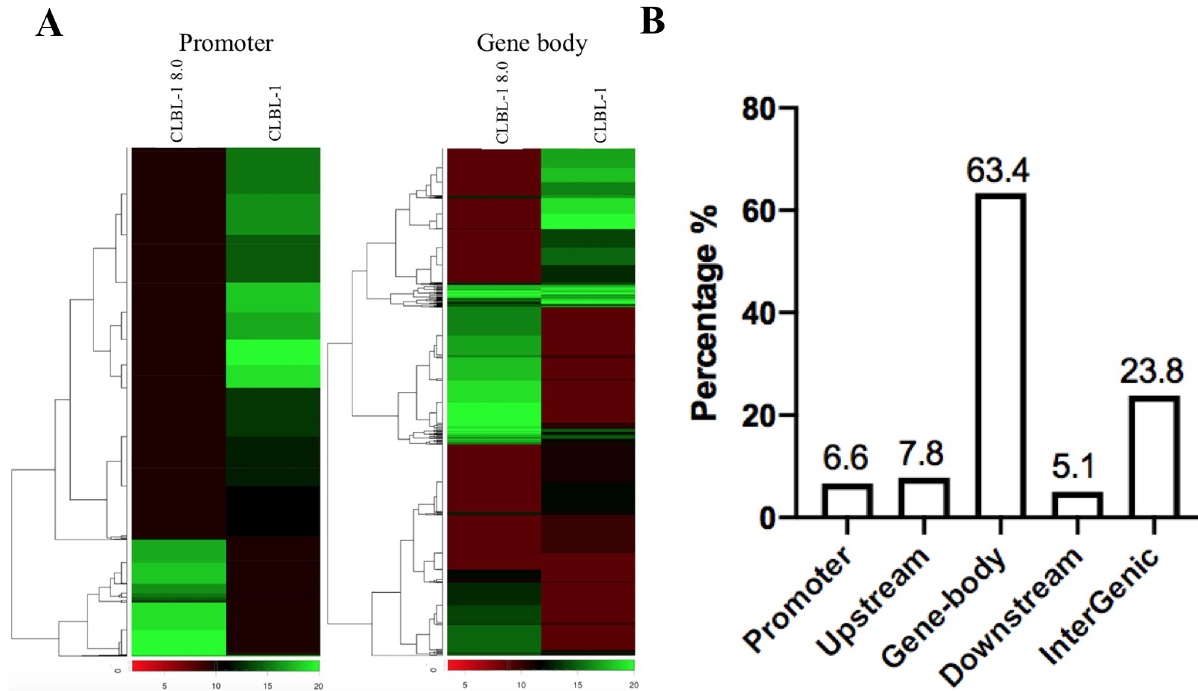
Fig 1. Genomic distribution of methylation changes in CLBL-1 and CLBL-1 8.0. (A) Heatmap depicting DNA methylation pattern between CLBL-1 and CLBL-1 8.0 in the promoter and gene-body regions. A greener color indicates the larger value of peak fold enrichment. (B) Bar chart showing the genomic distribution of CpG sites with altered DNA methylation patterns in CLBL-1 8.0 as compared to CLBL-1. “Upstream” is defined as 5000 bp upstream of Transcription start site (TSS), and “Promoter” is defined as 3000 bp upstream of TSS.